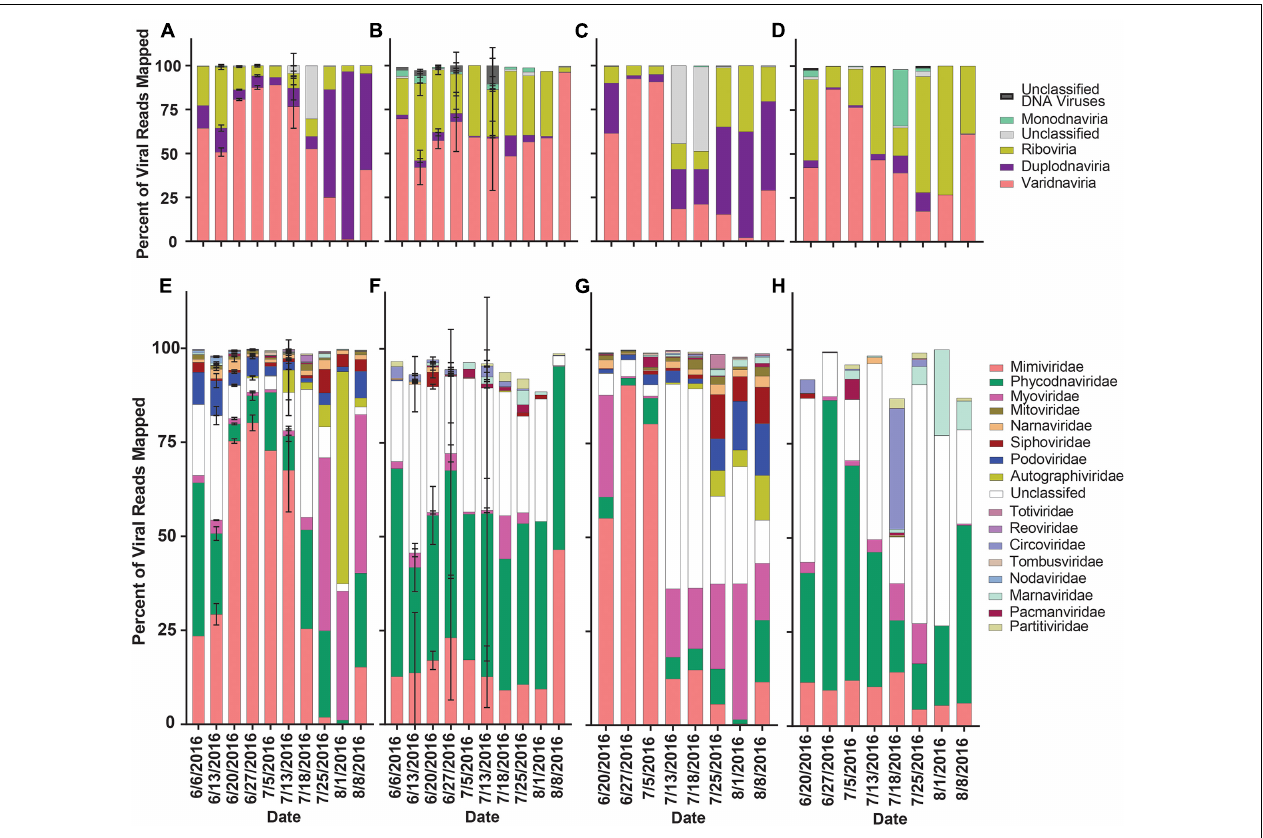
FIGURE 6 | Relative proportion of reads mapped to viral contigs by phylogeny by date and sampling location. Proportions of reads mapped to viral contigs from (A) rRNA-reduced and (B) poly-A selected Quantuck Bay libraries by realm. Proportions of viral contigs from (C) rRNA-reduced and (D) poly-A selected Tiana Beach libraries by realm. Proportions of read mapped to viral contigs from (E) rRNA-reduced and (F) poly-A selected Quantuck Bay libraries by family. Proportions of viral contigs from (G) rRNA-reduced and (H) poly-A selected Tiana Beach libraries by family. On dates where multiple samples exist, standard deviation is shown by error